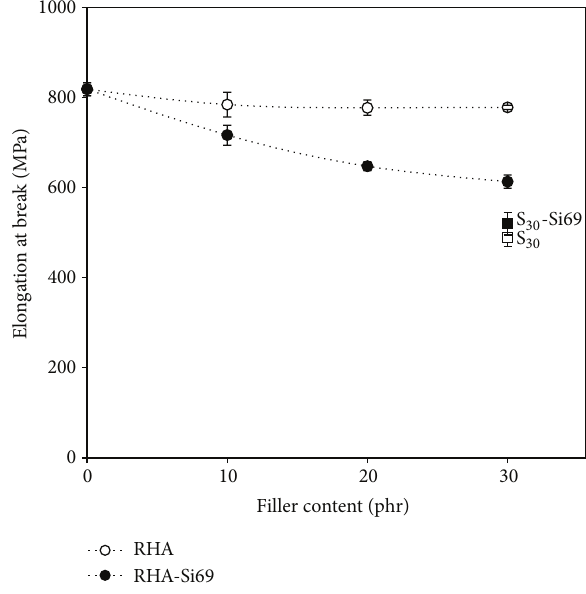
Figure8:ElongationatbreakofgumandfilledENR-25vulcanizates with various RHA contents and 30 phr of silica with and without silane coupling agent